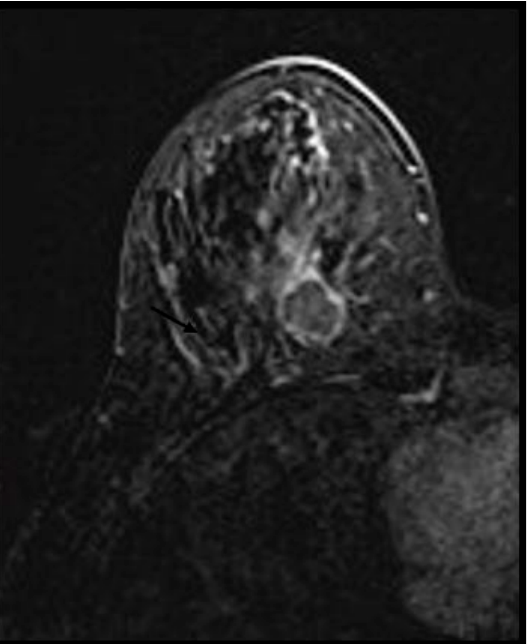
Figure 5. Triple negative breast cancer in a 32-year-old woman—rim enhancement on subtracted.